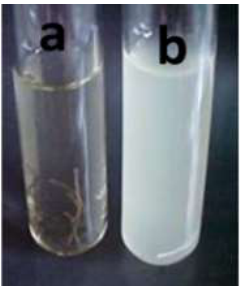
Figure 8. Difference in turbidity ( b ) before and ( a ) after nano treatment of sewing threads [25].